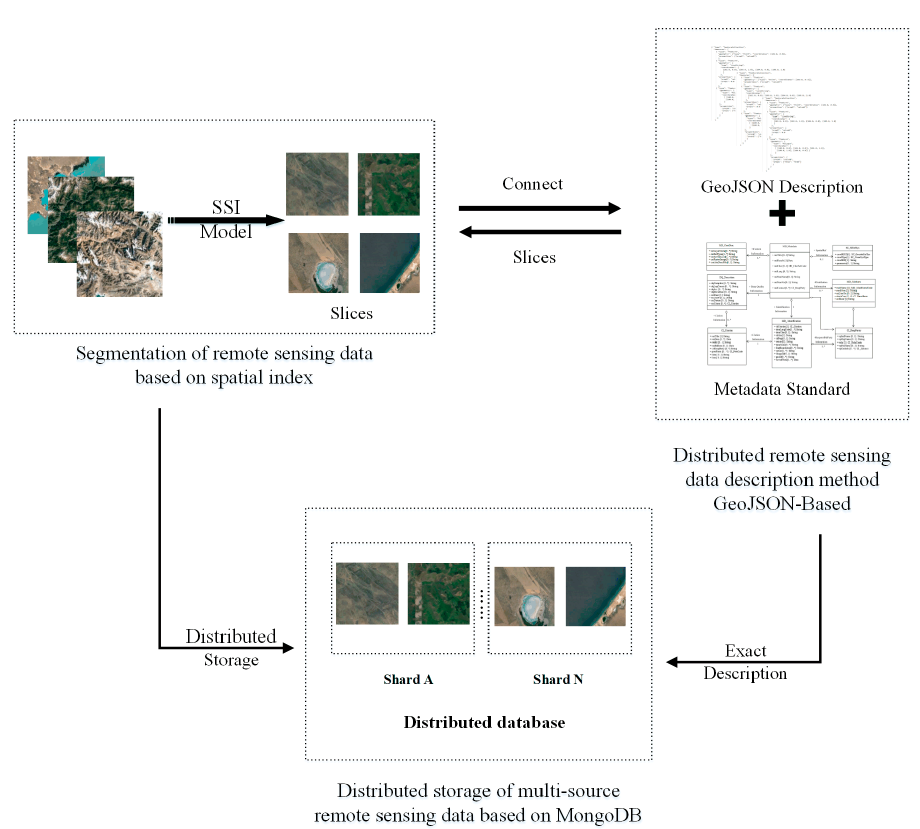
Figure 3. Distributed remote sensing data description method Geo-JavaScript Object Notation (GeoJSON)-Based logic diagram.